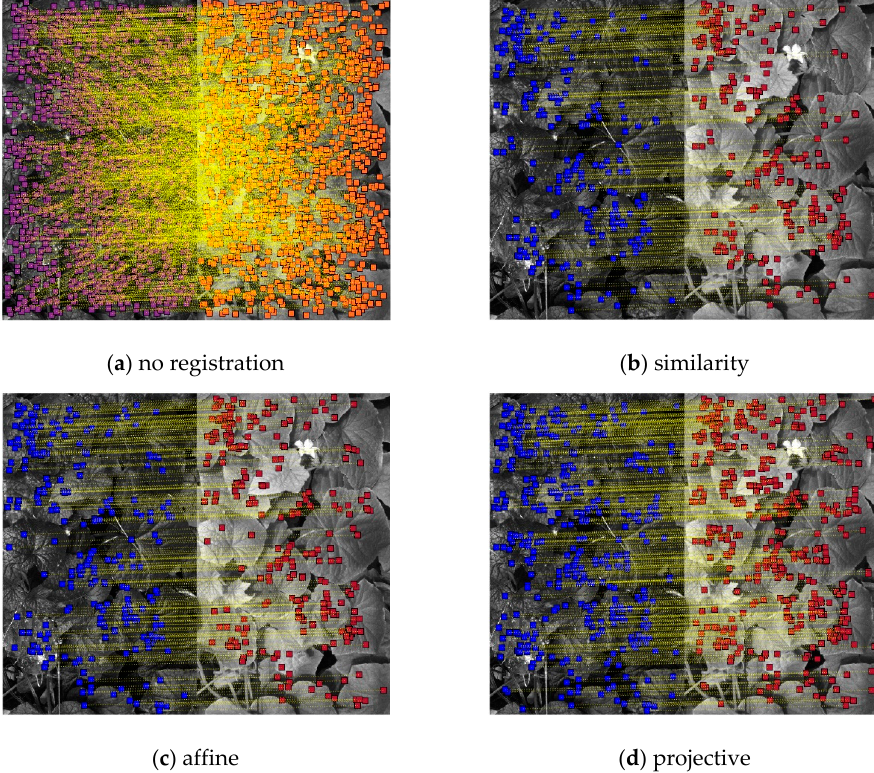
Matching point connector between the blue and red-edge images;